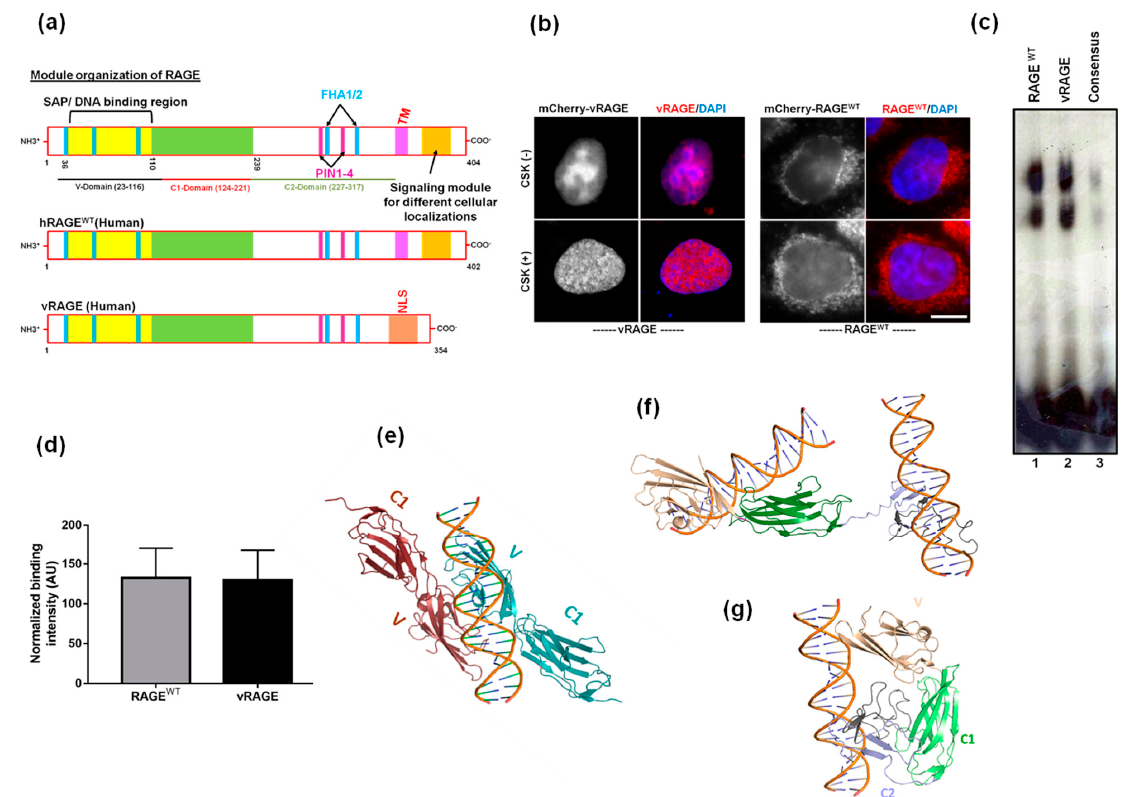
Figure 1. Comparative analysis of DNA binding abilities of RAGE WT and vRAGE. ( a ) A comparative pictorial representation of domains associated with the nuclear function of RAGE WT and a RAGE variant-V (vRAGE). The positions of domains (V, C1 and C2) are marked below the respective representation. ( b ) Representative images of Hela cells ectopically expressing mCherry-vRAGE (left) or mCherry-RAGE WT (right) shows the localization of vRAGE or RAGE WT (red) and the DAPI (Blue). These cells were either left un-extracted ( − ) or were extracted (+) with CSK buffer before fixation. The fluorescence of mCherry (no antibody) was used for detecting the vRAGE or RAGE WT . Blue color represents DAPI (Scale 6 µ m). ( c ) In a native gel shift assay, a 64mer dsDNA (~60ng), labeled at the 5 (cid:48) end of one of the strands and was incubated with either RAGE WT or vRAGE (25nM) as described in methods. The consensus served as a negative control. ( d ) Densitometry quantification plot of the gel shift assay described in figure (Figure 1c). ( n = 2) ( e ) The ribbon-diagram illustration of the nucleic acids bound human RAGE WT crystal structure (PDB accession code 4oi7). Nucleic acids interact largely at the dimeric interface between variable domains (V). The C2 domain is not present in the crystal structure. ( f ) Ribbon-diagram illustration of a nucleic acid sequence containing the vRAGE model structure after molecular docking. This shows that the c-terminal region (C2) of vRAGE is also capable of binding to the DNA. ( g ) The ribbon-diagram illustration of a nucleic acid sequence with the v RAGE model structure in a bent state after molecular docking and structural